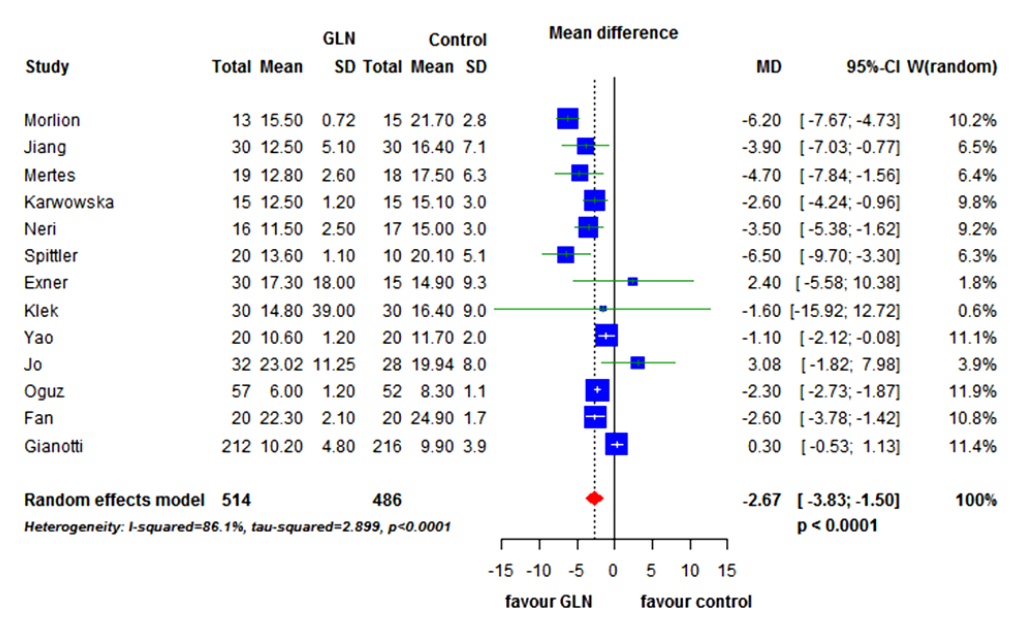
Figure 6. Forest plot for length of hospital stay comparing GLN vs. control. GLN: glutamine, MD: mean difference, CI: confidence